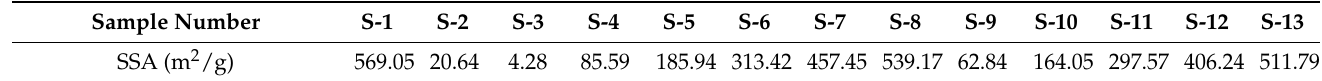
Table 4. Specific surface areas (SSA) of mixed soil